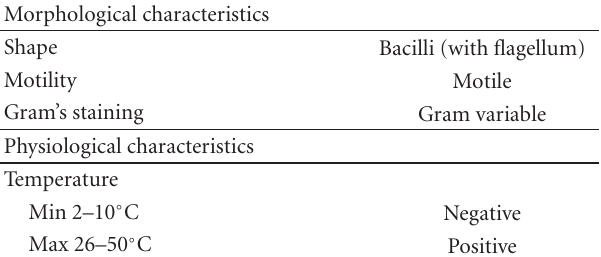
Table 1: Phenotypic characteristics of Sporosarcina aquimarina SjAM16103.